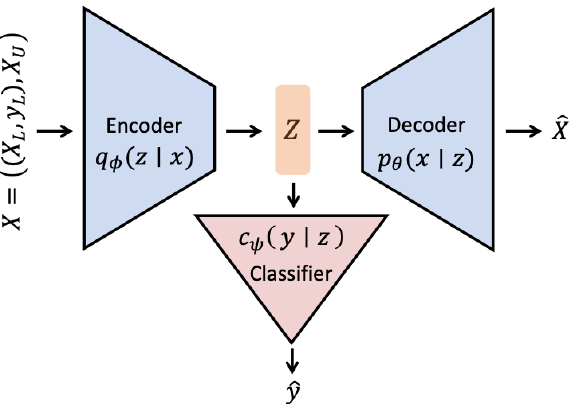
Figure 1. Graphical illustration of RESAD’s architecture and its